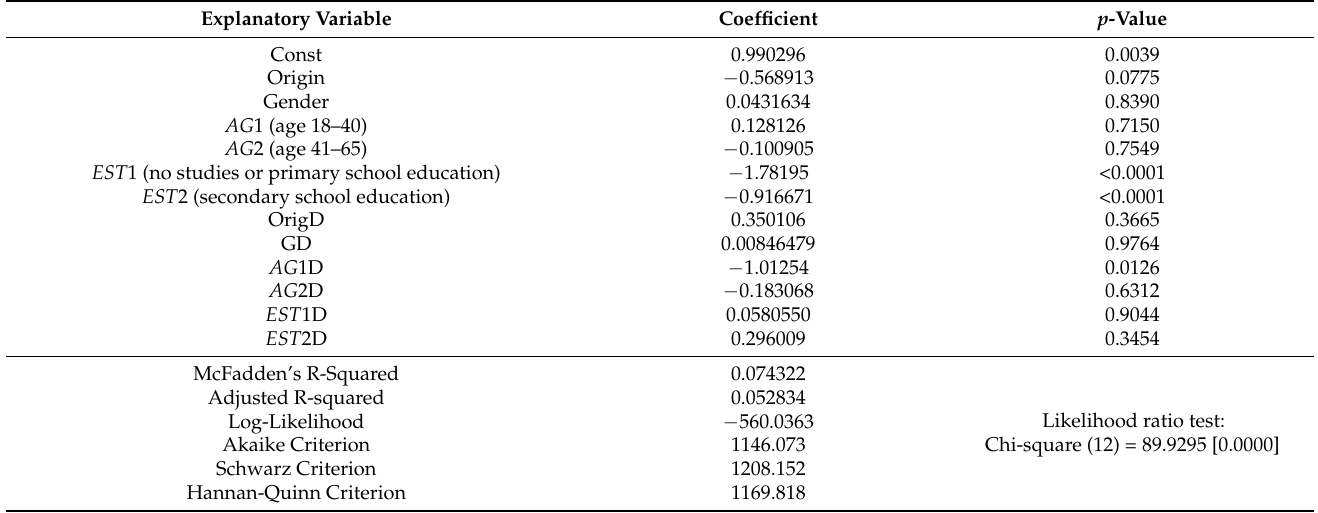
Table 2. Estimation of the unrestricted